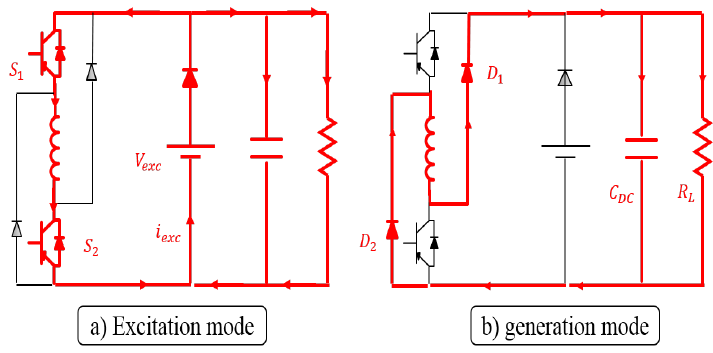
Figure 3. SRG operating modes.